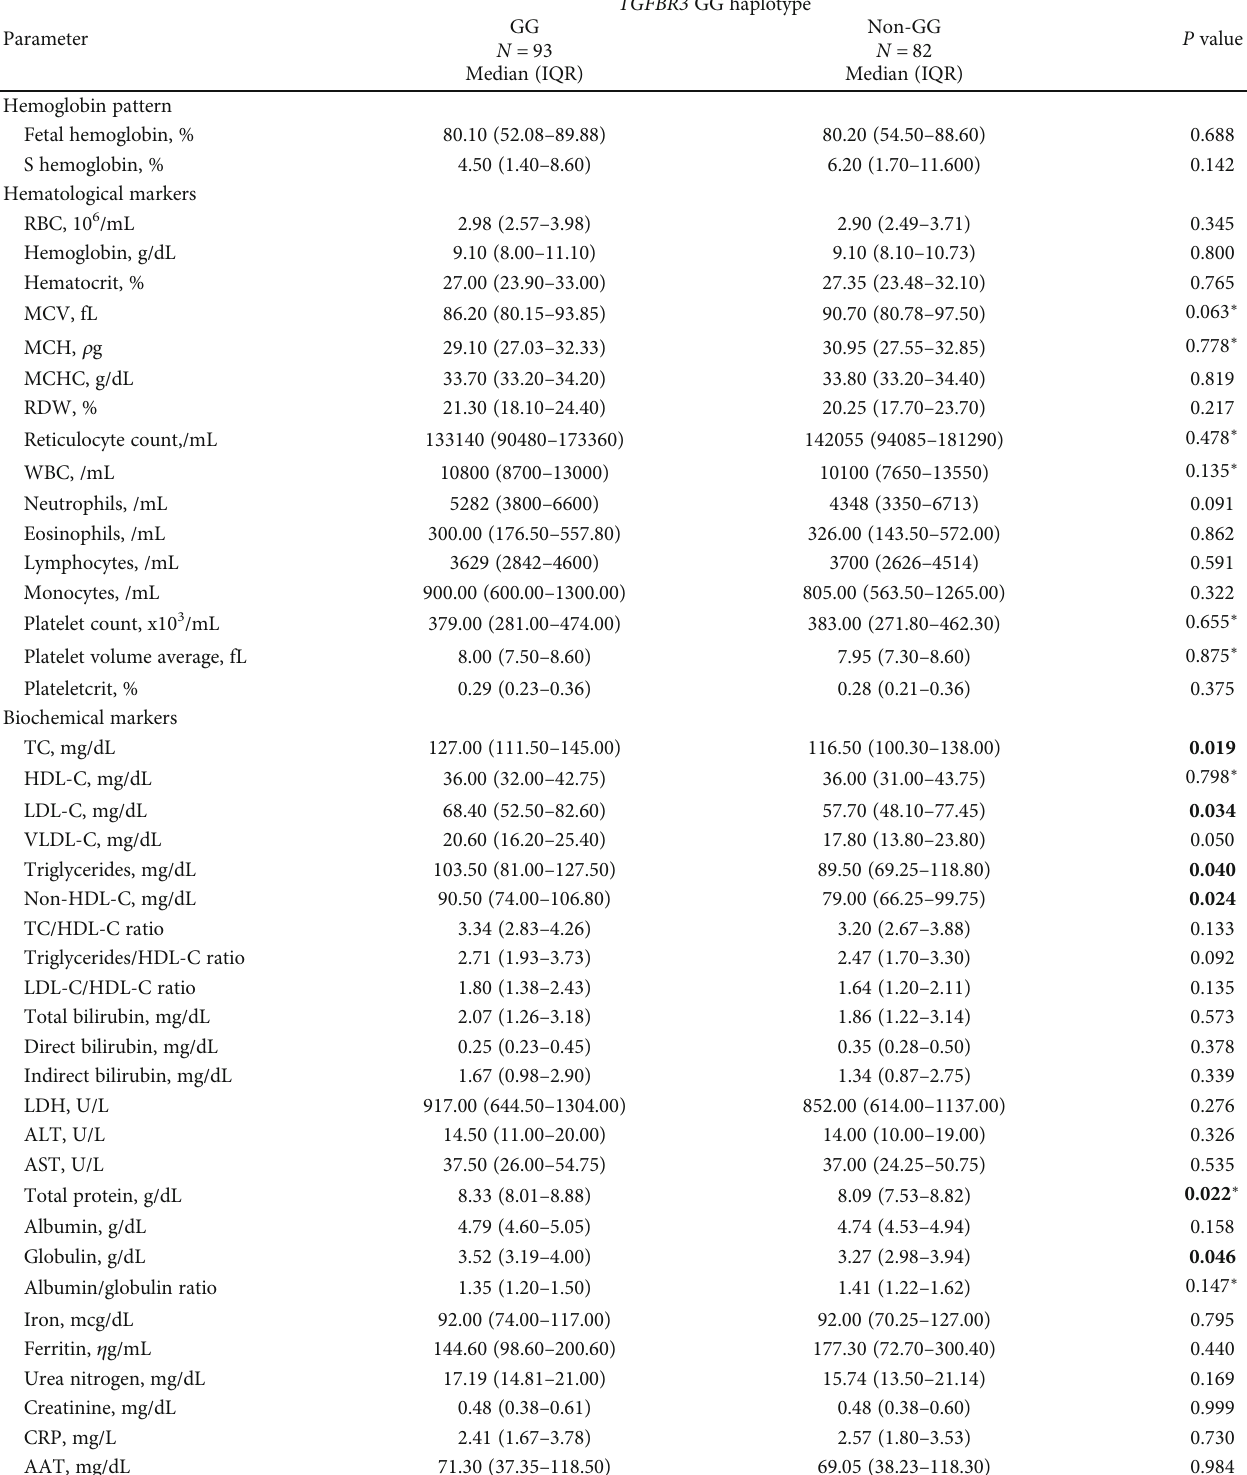
Table 6: Association of TGFBR3 GG haplotype with laboratory